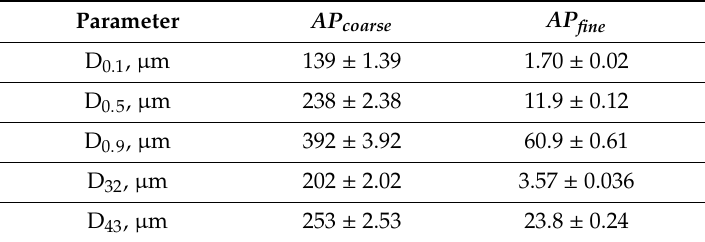
Table 1. Ammonium perchlorate (AP) particle size distribution.